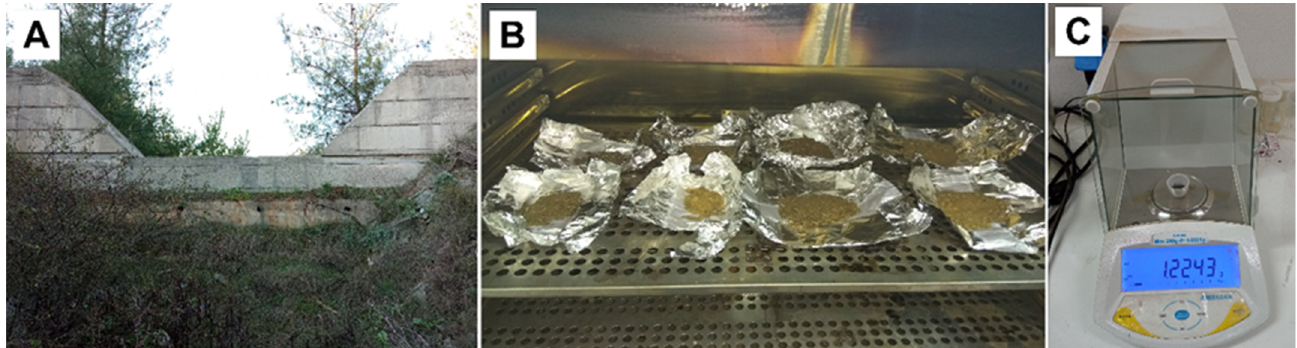
Figure 2. Distribution of monthly precipitation and temperature in the area of Thessaloniki.